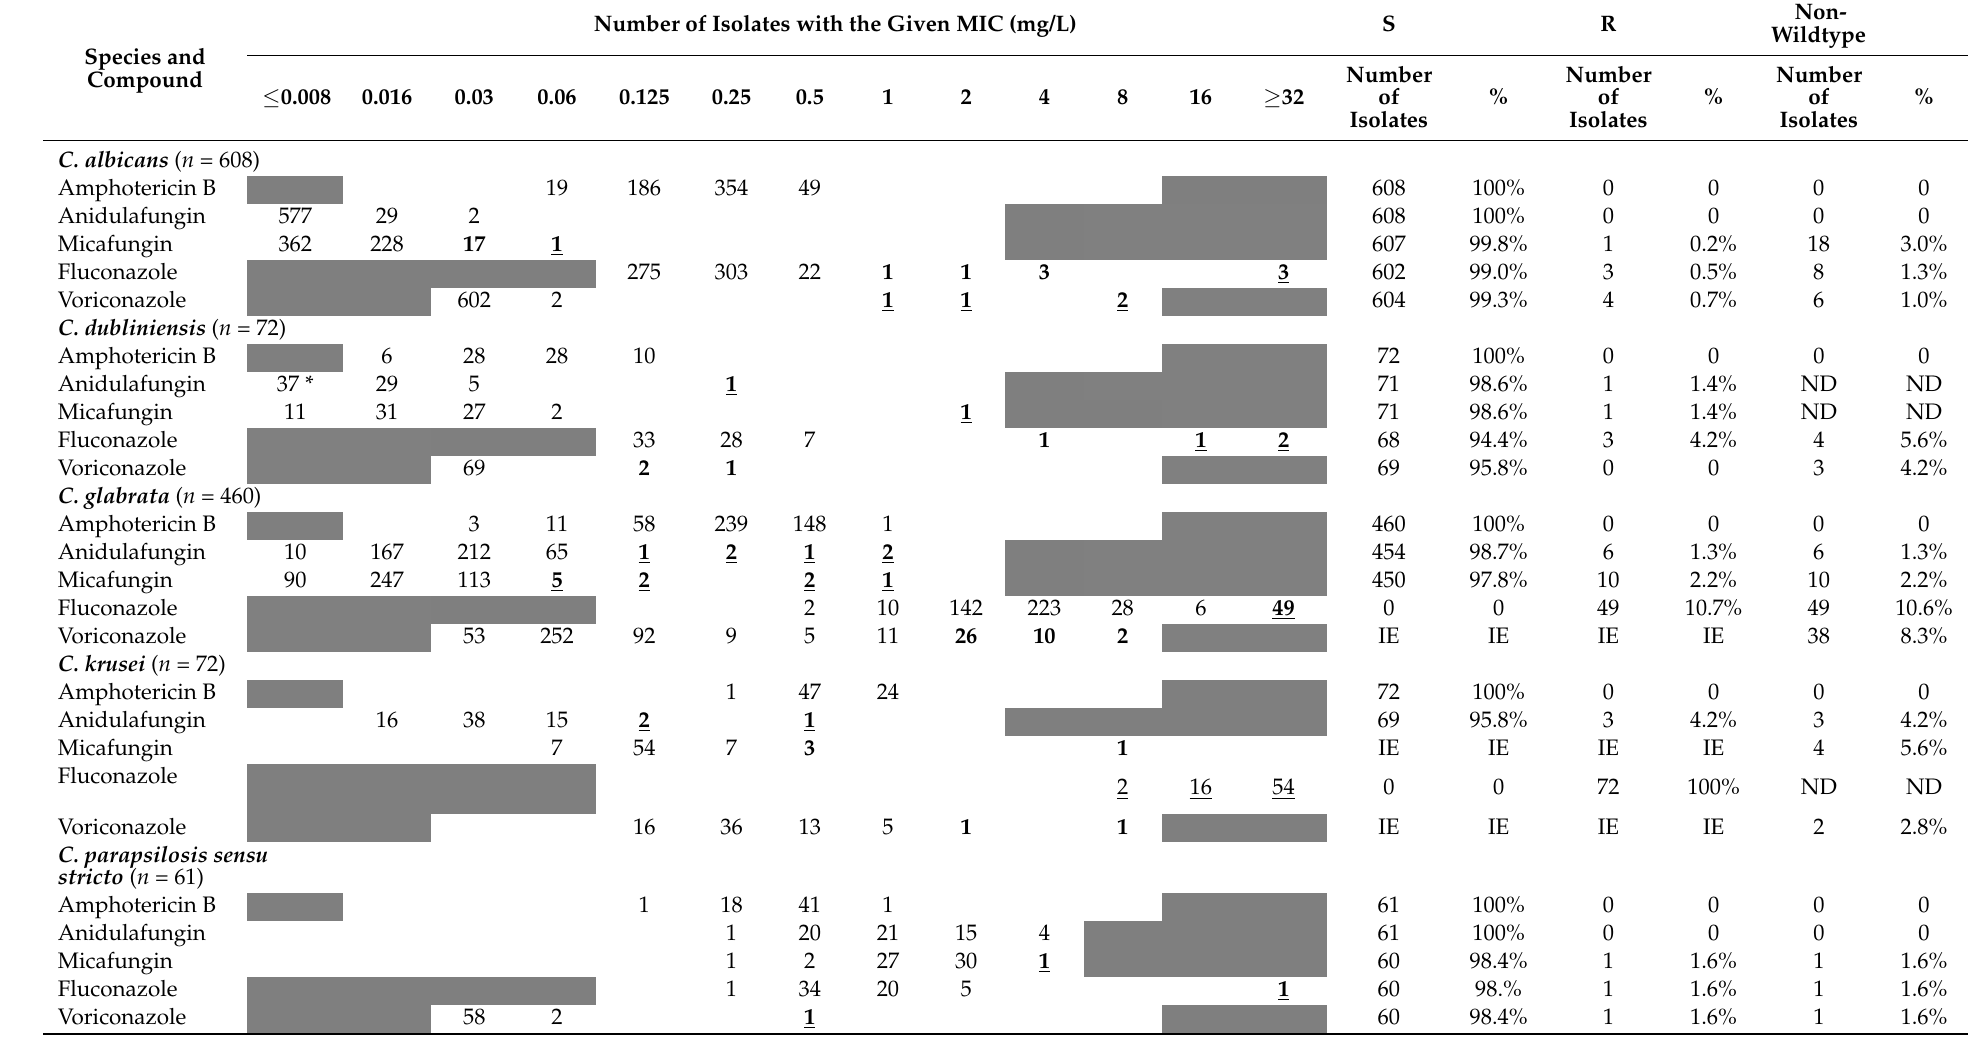
Table 3. Susceptibility table for fungal blood isolates in 2016 to